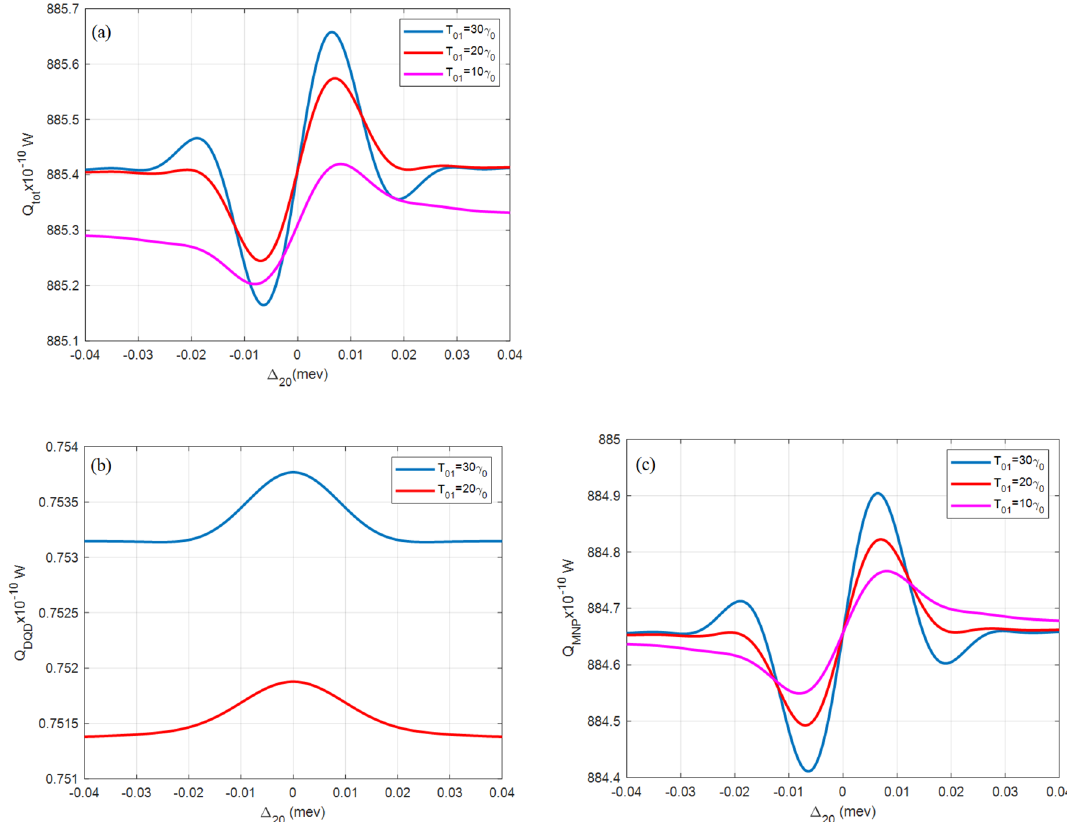
Figure 5. ( a ) The total ( Q tot ) , ( b ) DQD ( Q DQD ), and ( c ) MNP ( Q MNP ) absorption rates from the DQD-MNP hybrid system at R = 20nm and a = 10nm at different values of the tunneling component T 01 as in the inset and (cid:31) 0 02 = 0.09meV , � 0 13 = 1.8GeV, T 32 = 8 γ 0